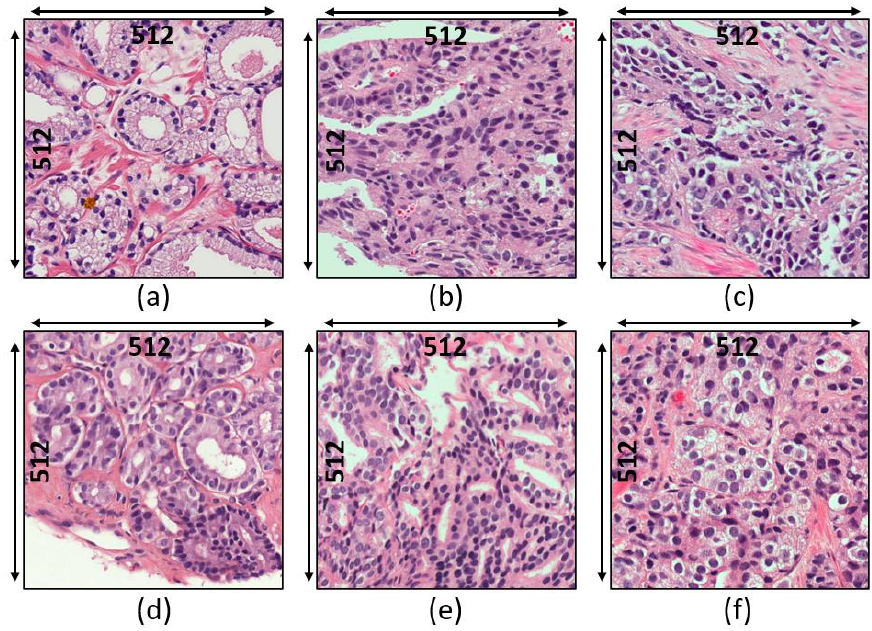
Figure 1. Histologic findings for each grade of prostate cancer. ( a – c ) Dataset 1: grade 3, grade 4, and grade 5, respectively. ( d – f ) Dataset 2: grade 3, grade 4, and grade 5,